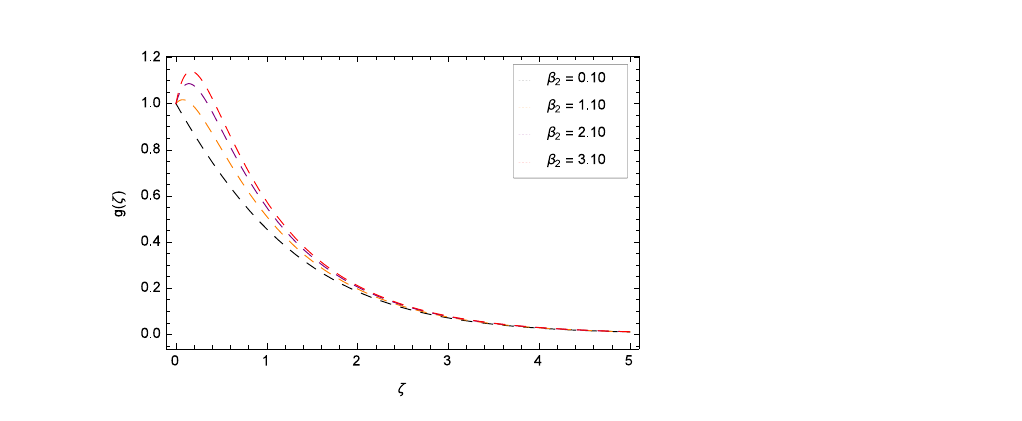
Figure 9. Pattern of graph curves on account of β 2 .